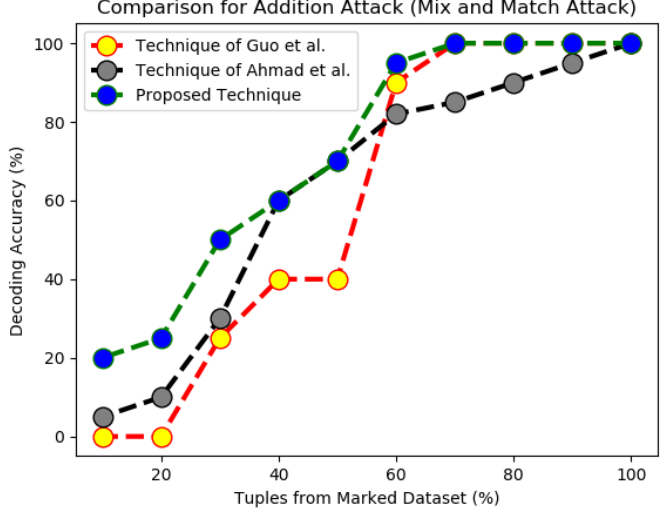
Figure 8. Comparison of techniques for addition